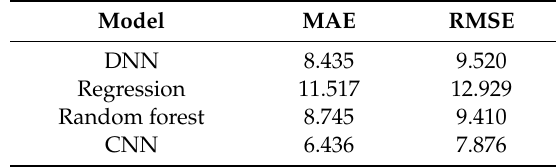
Table 4. The results for the four models using the average cumulative sum method.